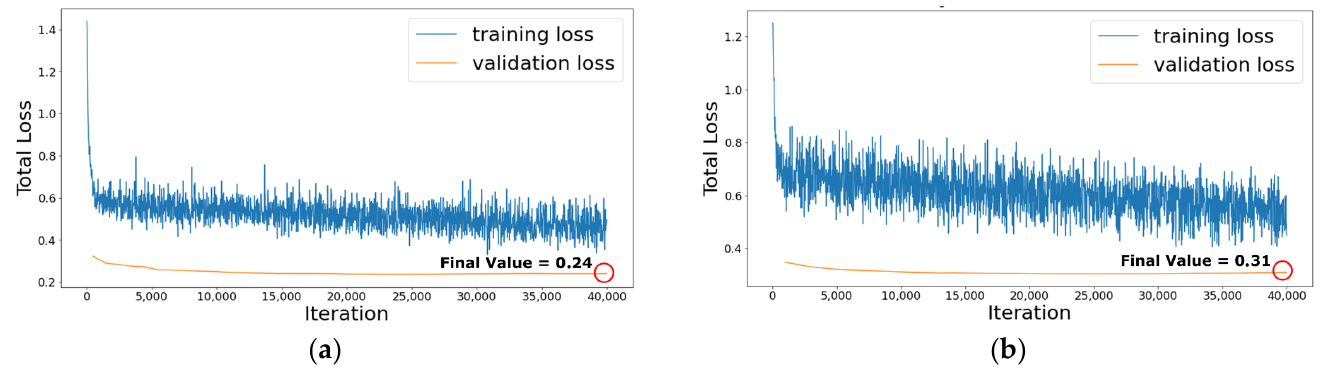
Figure 14. Training losses for ( a ) Resnet-50 ( b ) Resnet-101.